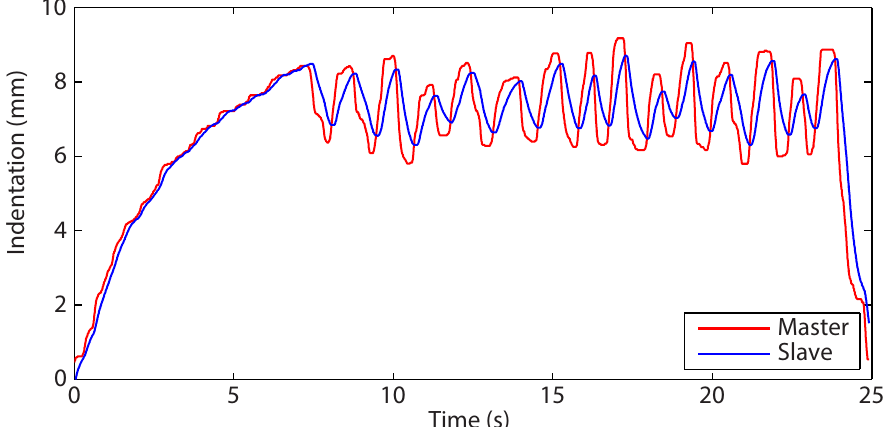
Figure 7. Position profiles for both the slave and master as the slave interacts with the polyurethane foam using the direct force-feedback